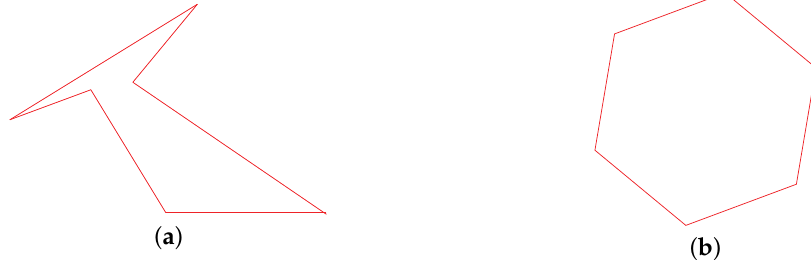
Figure 3. ( a ) Initial inverted hexagonal element. ( b ) Hexagonal element after applying the modified transformation for one hundred